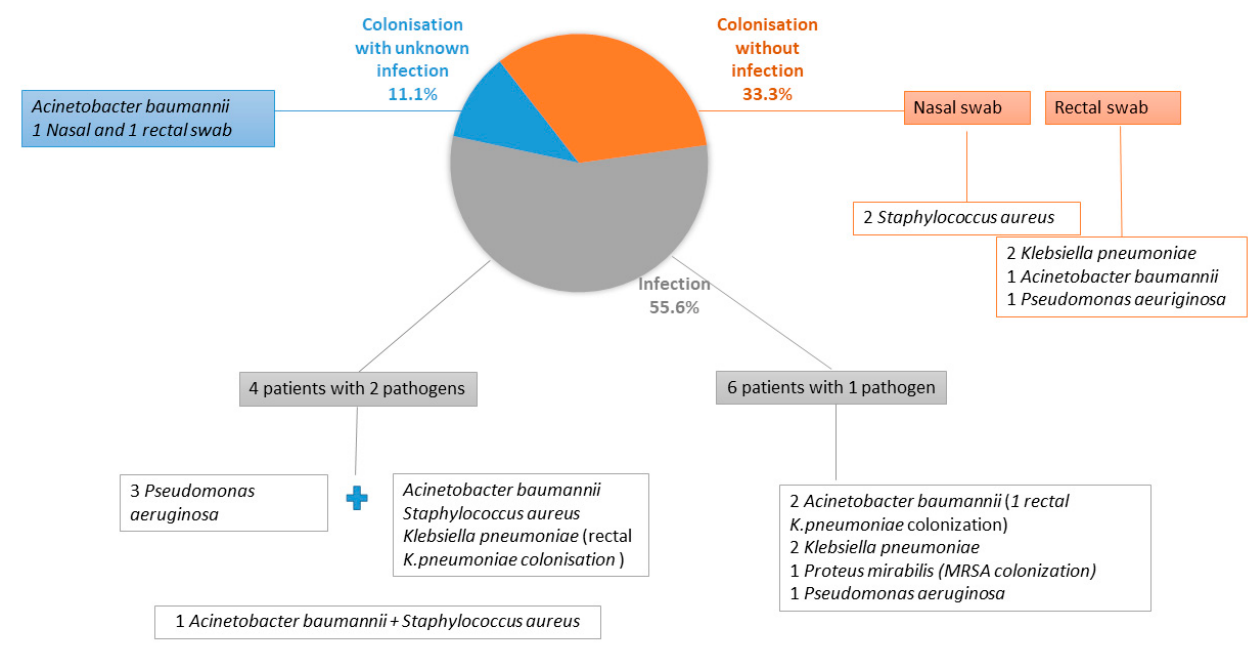
Figure 1. Distribution of colonisation without infection/MDRO or XDRO infection/colonization with unknown infection along with pathogens responsible, in the study cohort.